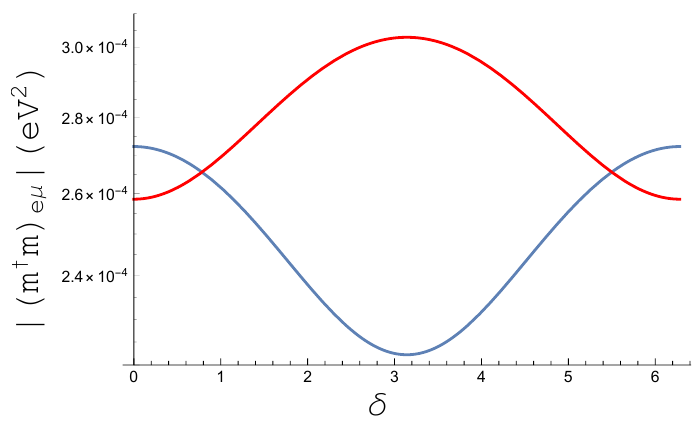
(cid:12) (cid:12) (cid:12) (cid:12)(cid:0) m † m (cid:1) (cid:12) Figure 1 . The parameter, constrained by the µ → eγ process at the MEG experi- (cid:12) eµ ment [99], as a function of the δ CP phase for the NO (Blue) and IO (Red) scenarios. All other parameters are fixed by the corresponding best fit parameters in table